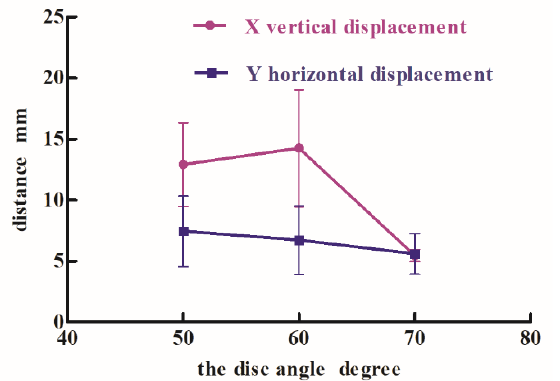
Figure 5. The influence of the soil covering process on the changes in seed displacement with various open angles of discs.